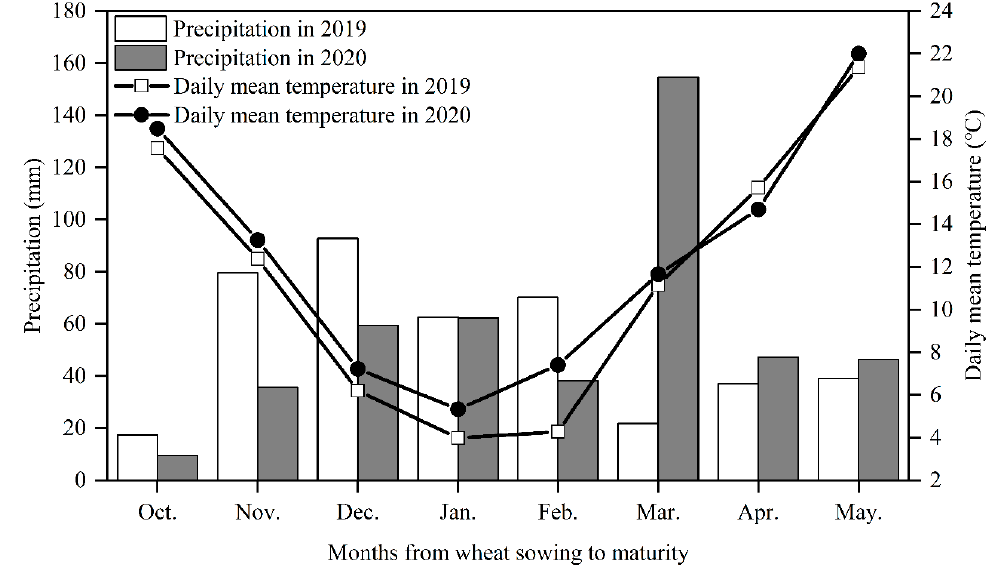
Figure 1. Precipitation and daily mean temperature during the wheat-growing seasons of 2018–